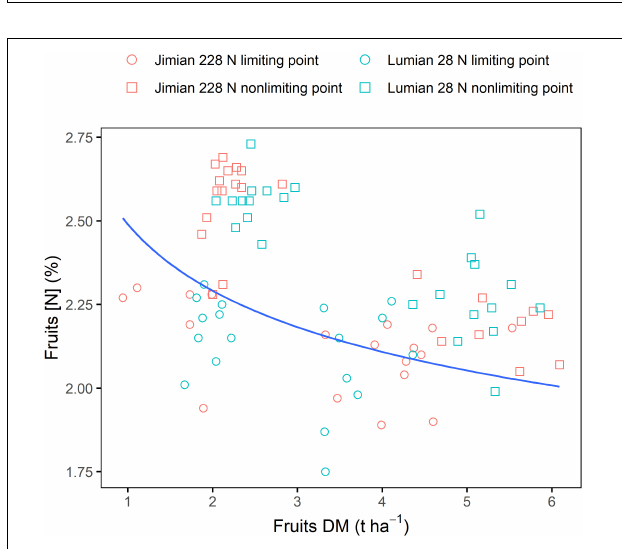
FIGURE 3 | The overall critical fruits N dilution curve across cultivar-years. DM, dry mass and [N], N concentration. Points shown for the mean values of the three replicate plots. The equation and fit statistics ( R 2 and P -value) are indicated for the relationship. Additionally, the general critical N curve ([N] c = 4.80 × DM − 0 . 34 ) is presented for C3 crops based on plant biomass (the black line).